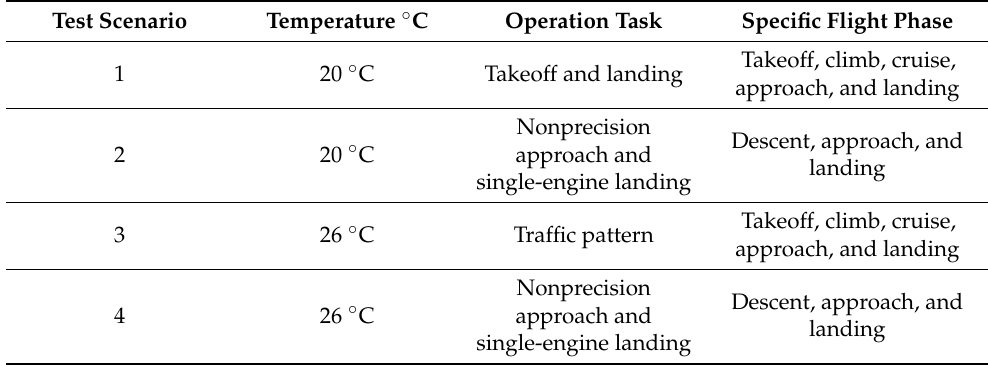
Table 1. Design of test